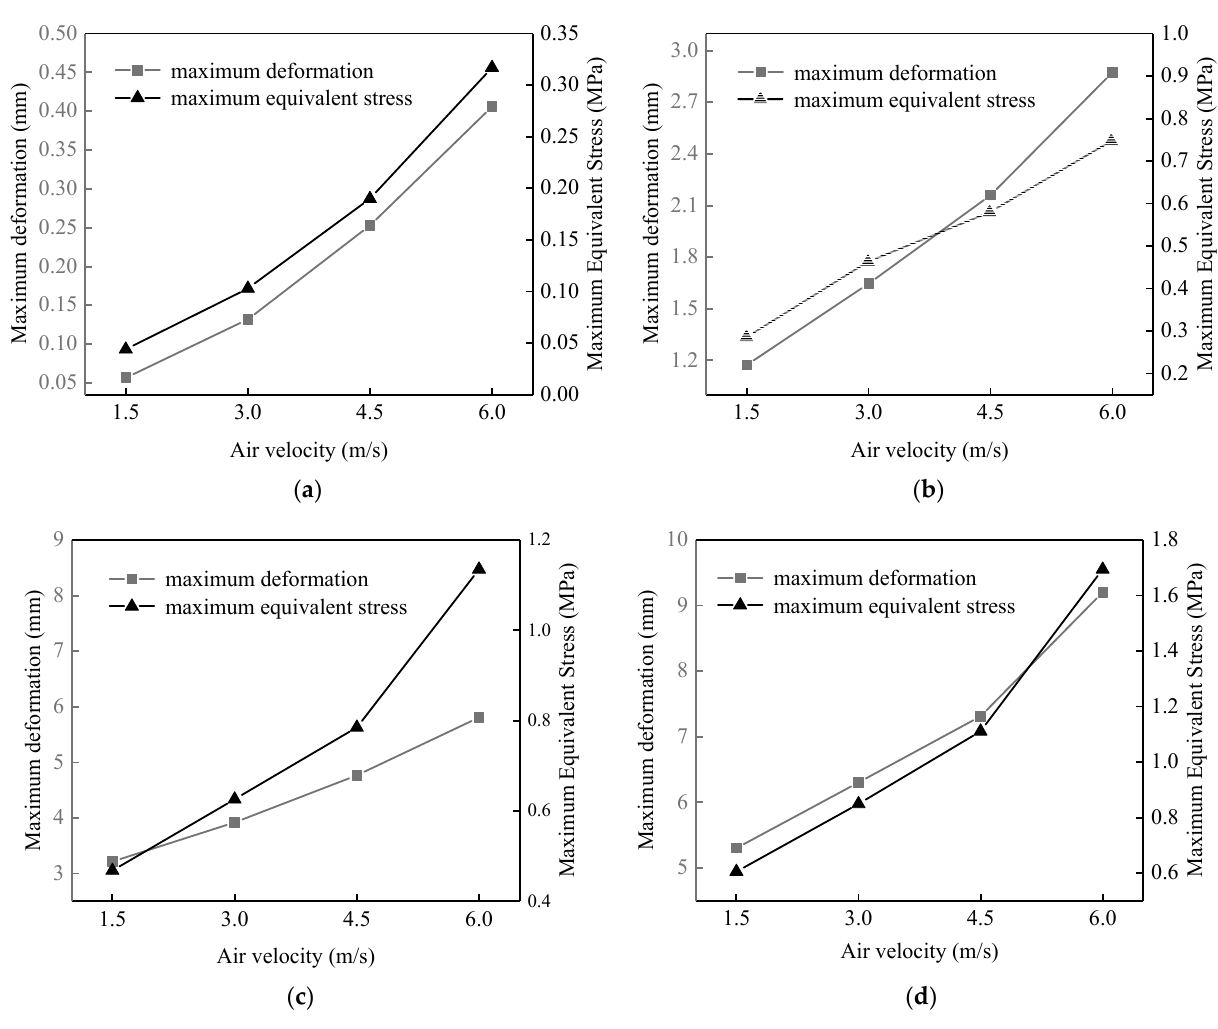
Figure 6. The maximum deformation and equivalent stress of fluid-structure interaction at different air velocities for different fiber lengths. ( a ) 100 mm; ( b ) 200 mm; ( c ) 300 mm; ( d ) 400 mm.